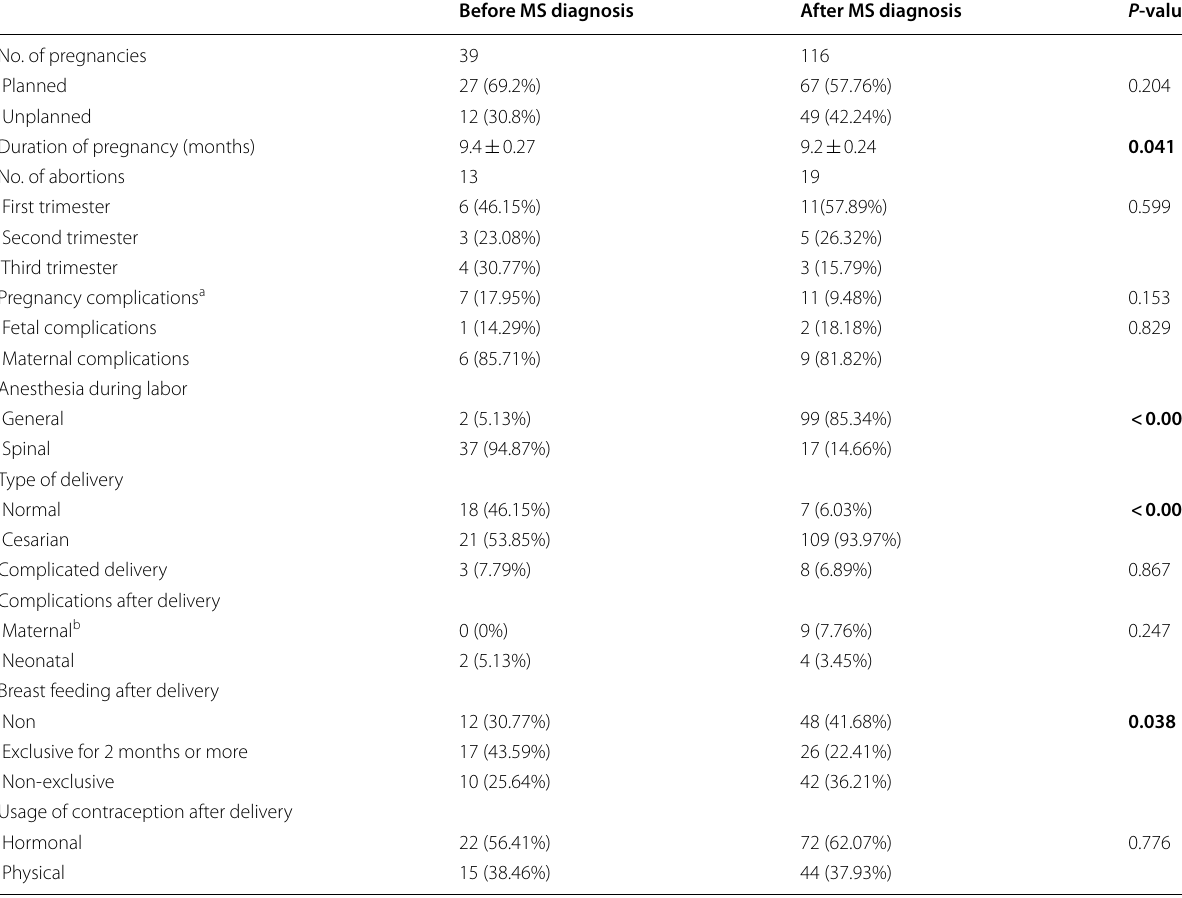
Table 2 Effect of MS on pregnancy and labor related